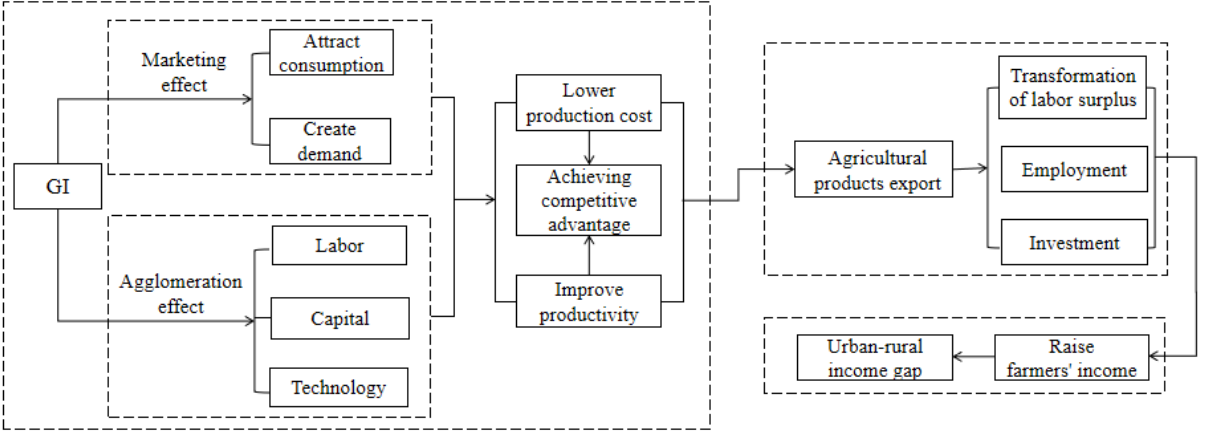
Figure 1. GI, agricultural products export and urban – rural income gap mechanism diagram.